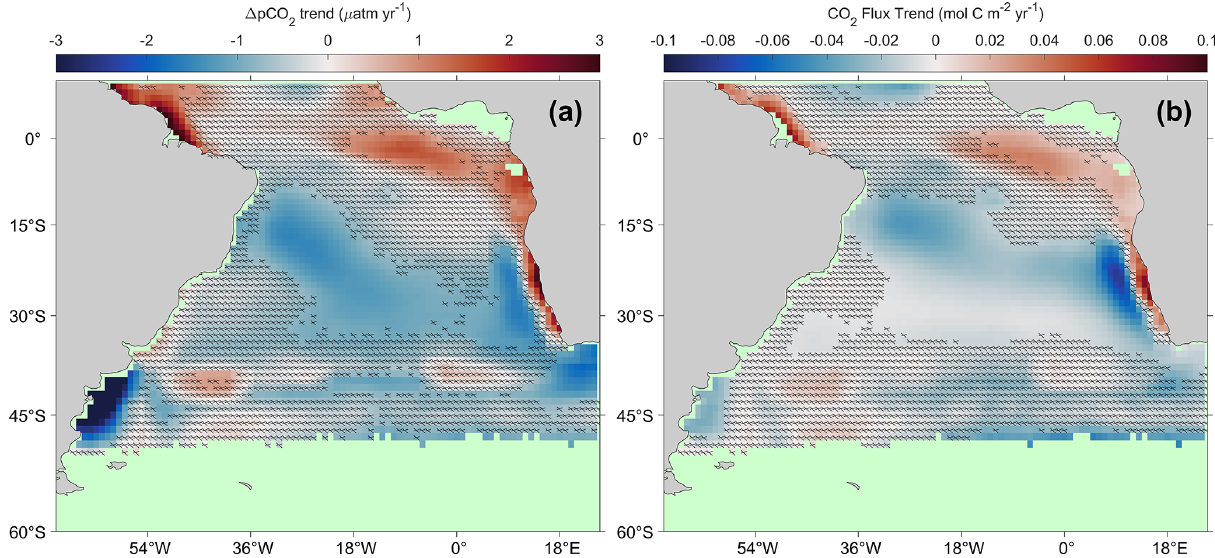
Figure 5. Linear trends in (a) (cid:49)p CO 2 and (b) the air–sea CO 2 flux between 2002 and 2018. Hashed areas indicate non-significant trends when accounting for the uncertainties. Green regions indicate insufficient data to calculate